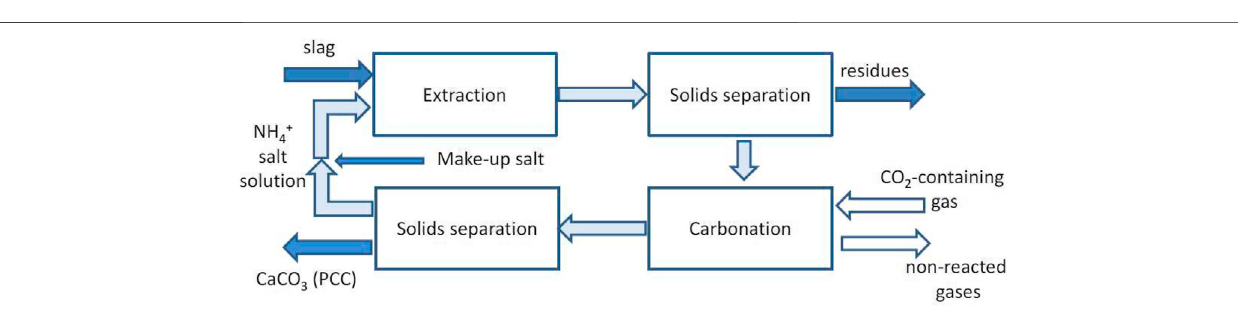
Frontiers in Energy Research |